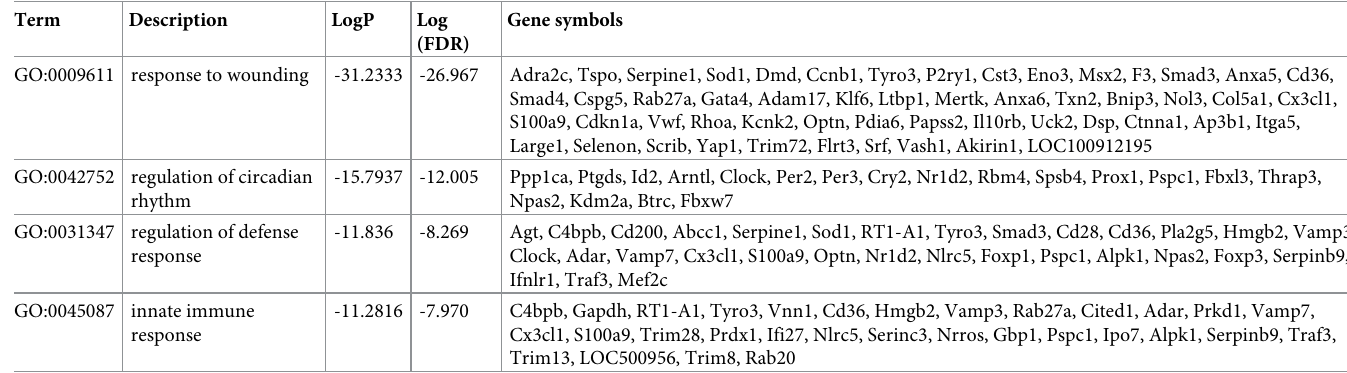
Table 2. Summary of top four significant pathways enriched by the 212 DEG reflecting short-term effects of repeated acute ISO exposures. Term